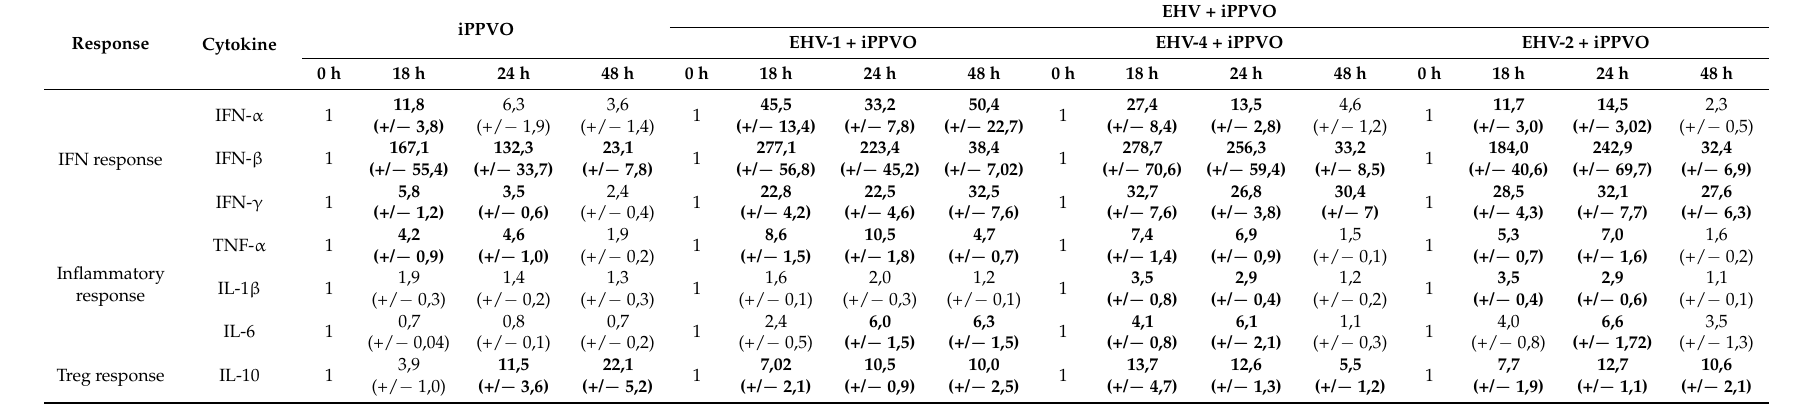
Table 3. Cytokine (IFN- α , IFN- β , IFN- γ , TNF- α , IL-1 β , IL-6, and IL-10) mRNA expression measured by real-time PCR in PBMC at 18 h, 24 h, and 48 h, after iPPVO treatment and after EHV-1, EHV-4, or EHV-2 infection with iPPVO treatment. n = 3 horses with 3 independent reverse-transcriptase PCR. Results are presented as the means ± SEM of the expression ratio (times-fold increase over the T 0 = 0 h). Significant differences from T 0 are indicating in bold ( p <